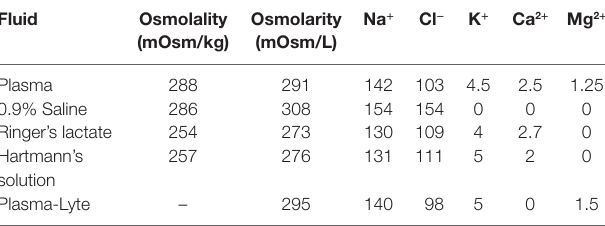
TABLe 1 | Composition of plasma and commonly used